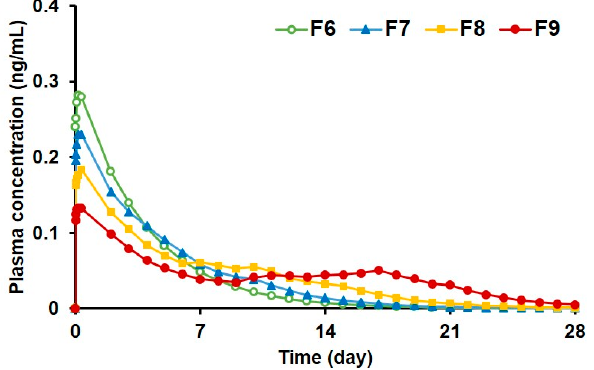
Figure 7. Predicted plasma concentration profiles of donepezil after intramuscular injection of the PLGA MS (F6–9) using the convolution technique. The pore-closed PLGA MS (F7–9) exhibited superior sustained release profiles compared to the porous PLGA MS (F6). Table 5. Predicted pharmacokinetic parameters for the PLGA MS formulations F6–9.